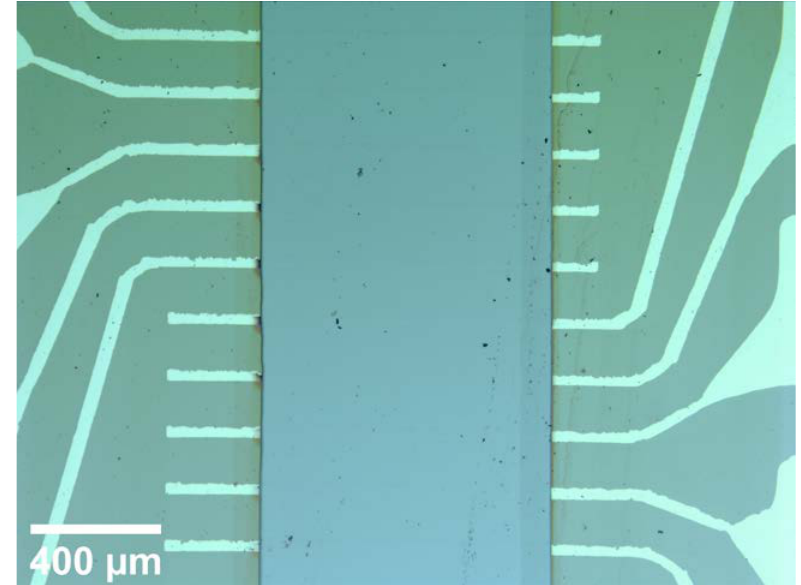
Figure 2. Optical micrograph of a sample with the nanocomposite film deposited across the contact line pattern.